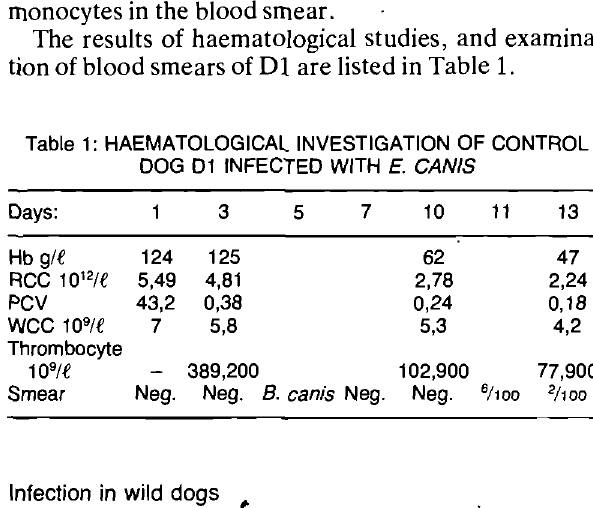
Table 1: HAEMATOLOGICAllNVESTIGATION OF CONTROL DOG 01 INFECTED WITH E. CANIS